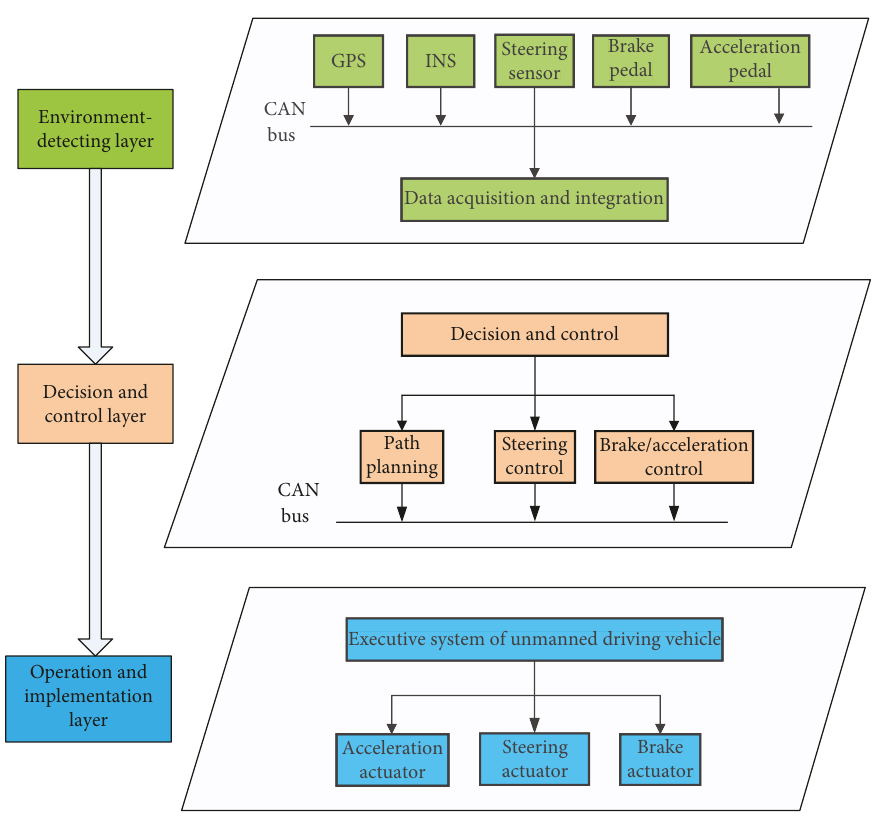
Figure 1: The con fi guration of the unmanned driving